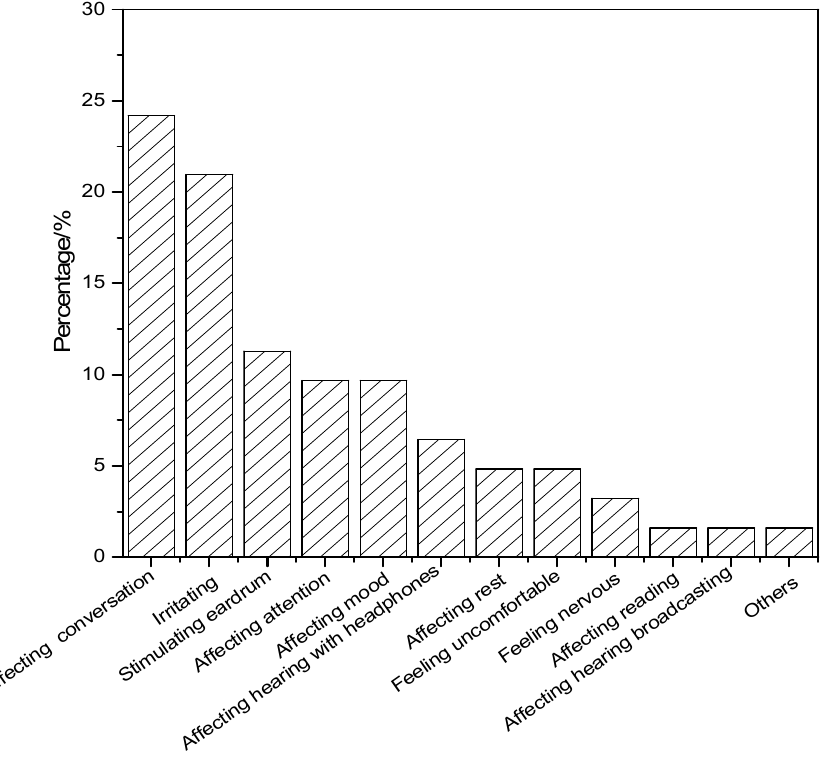
Figure 5. Main noise effects on passengers.